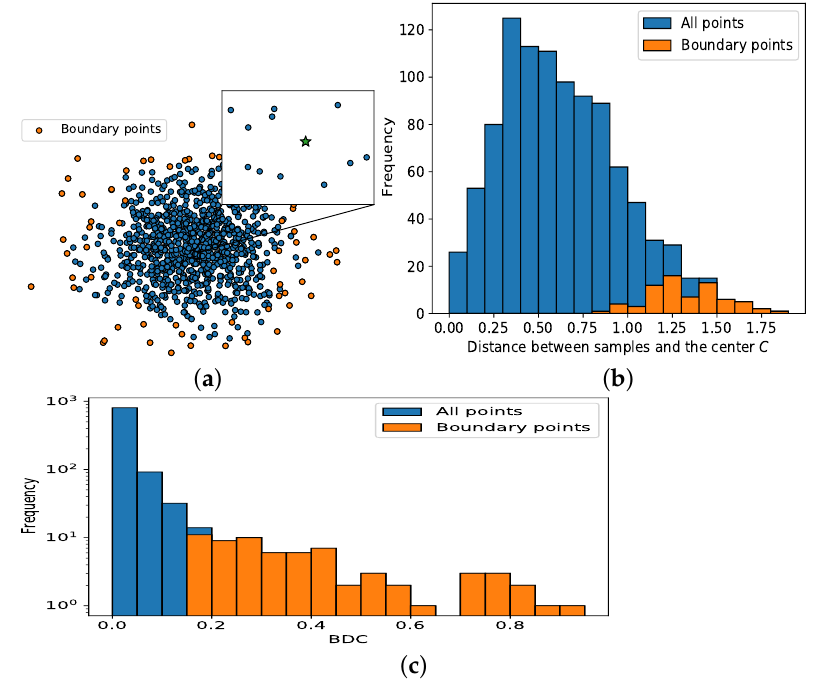
Figure 4. The center point of a cluster, such as the ‘Star’ point in ( a ), its k-NNs are approximately uniformly distributed around it. In contrast, the k-NNs of the boundary point tend to be distributed on one side. In ( a ), the ‘Boundary points’ are the detection results from the proposed method. ( b ) shows the distance distribution in ( a ), and the center C is obtained by averaging all points. ( c ) shows the BDC distribution of all points in ( c